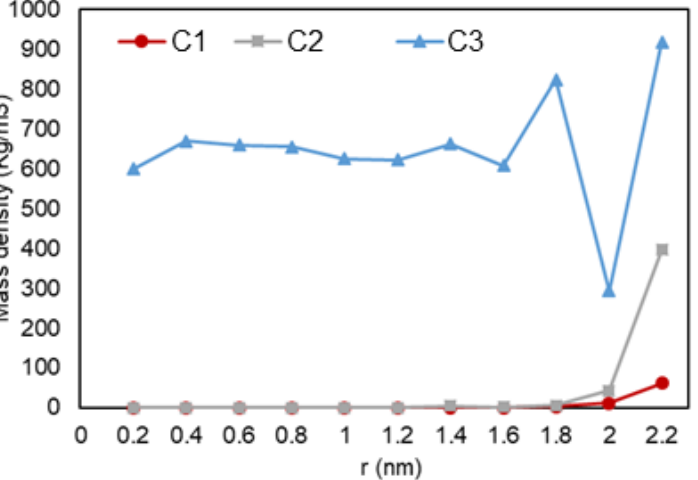
Figure 8. Heptane mass density vs. radial position in C1 (gas phase in bulk), C2 (two-phase in bulk), and C3 (liquid phase in bulk) conditions.